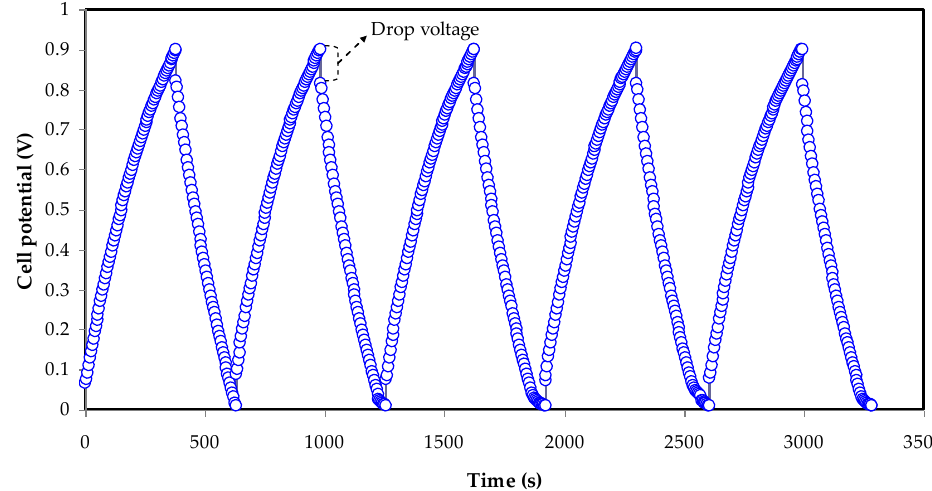
Figure 5. The GCD performances of the fabricated EDLC.